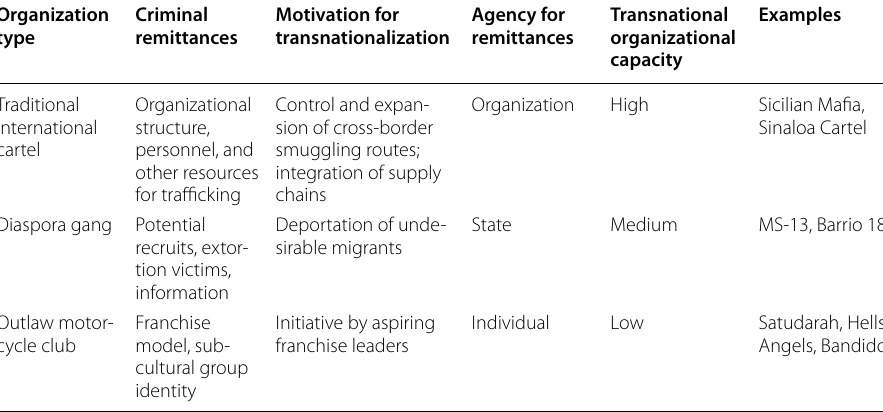
Table 1 Transnational criminal remittances by organization type Organization